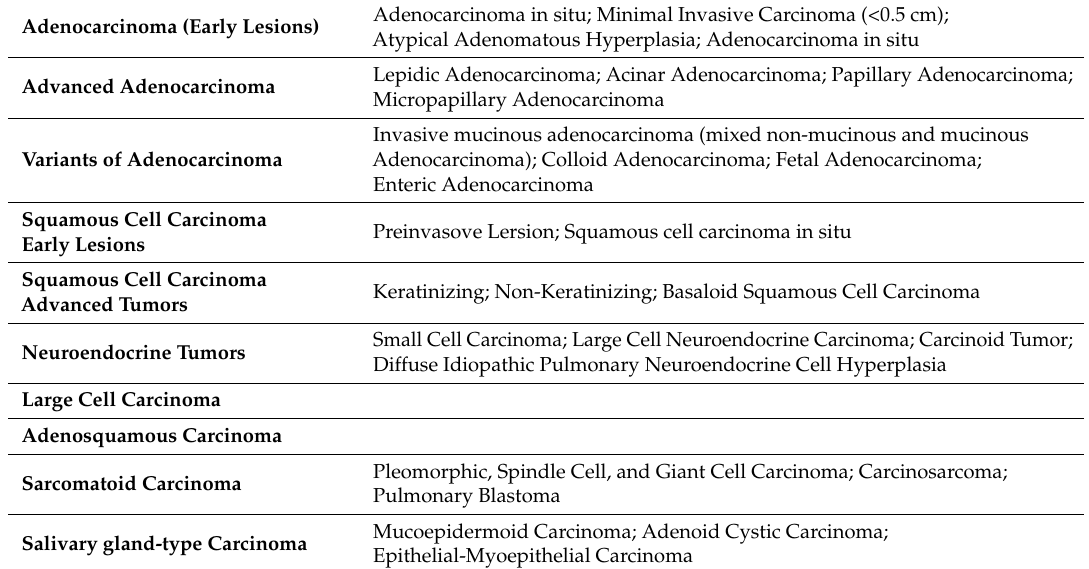
Table 1. Classification of the main types of lung cancers following WHO